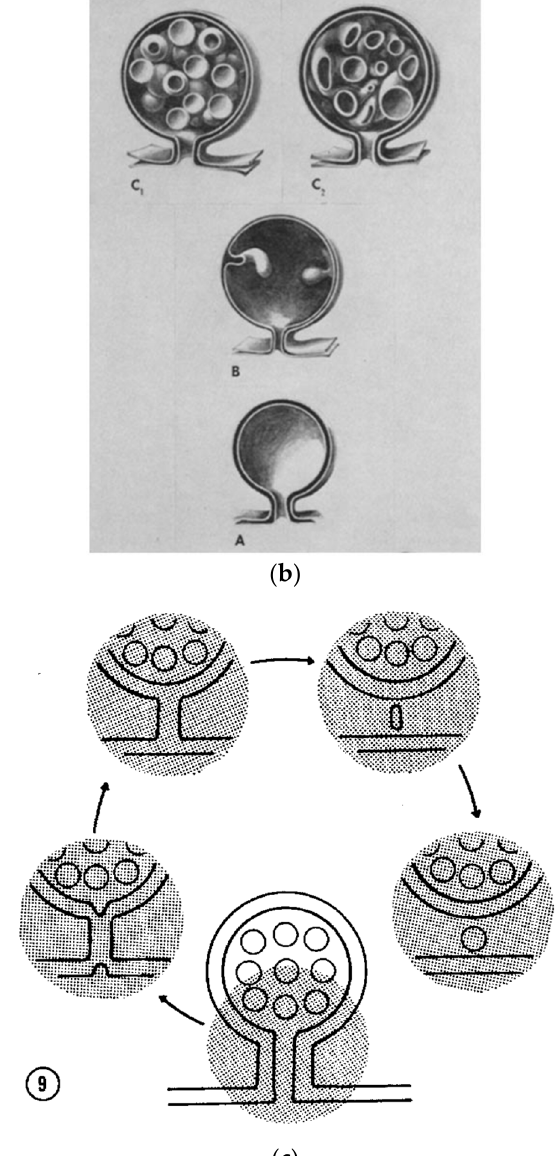
Figure 2. ( a ) Section through a cell of gas gland of perch fish showing nuclear blebbing (long arrows). Nuclear blebs are filled with “fine vesiculae” with a diameter of 51–72 nm and 168–290 nm. Ultrastructure appearance of nuclear bleb is comparable to multivesicular bodies that originate from endosomes in the cytoplasm. Encircled 2 is the original label from Kilarski and Jasi´nski manuscript. Magnification: × 5250 [24]. ( b ) Illustration depicts the development of round-shaped intraluminal vesicles (A-C1) and tubular-shaped vesicles (A-C2) from single in-foldings of the internal membrane of nuclear bleb (multivesicular body type II). The mechanism of vesicle formation in nuclear blebs is similar to development of ‘intraluminal vesicle’ in cytoplasmic endosomes. ( c ) Illustration labeled as encircled 9 depicts formation of a connecting neck that separates from the external nuclear membrane, tearing the nuclear bleb from the nucleus, and setting it free in the cytoplasm. Nuclear blebs are filled with small vesicles. The intermediate vesicle (a small round structure) formed from the neck of nuclear bleb is seen between nuclear membrane and separated nuclear bleb. Figure 2 is adapted with permission from Wincenty Kilarski, Andrzej Jasi´nski; The formation of multivesicular bodies from the nuclear envelope. J. Cell Biol. 1 May 1970; 45 (2): 205–211. doi:10.1083/jcb.45.2.205